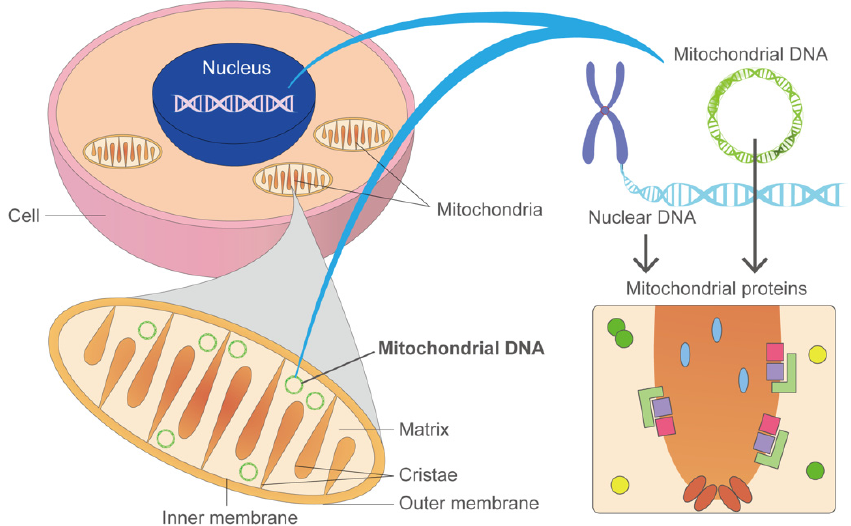
Figure 1. Mitochondrial diseases are caused by genetic variants in the nucleus and mitochondria DNA (nDNA and mt DNA, respectively). Most DNA is packaged in chromosomes in the nucleus, but a small amount of DNA is also present in the mitochondria. This genetic material is called mtDNA. There are 37 genes in mitochondrial DNA that are all essential for the normal functioning of mitochondria. Thirteen of these genes provide instructions for making enzymes involved in oxidative phosphorylation. Genes that cause mitochondrial diseases are found in both nDNA and mtDNA.